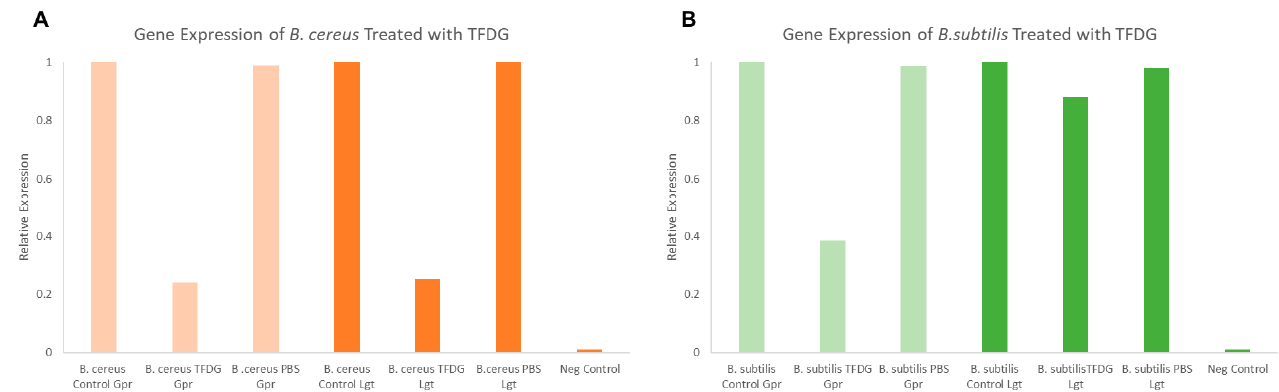
Figure 7. Semi-quantitative RT-PCR lgt and gpr gene expression analysis of Bacillus spore when treated with TFDG. ( A ) B. cereus spores; ( B ) B. subtilis spores.